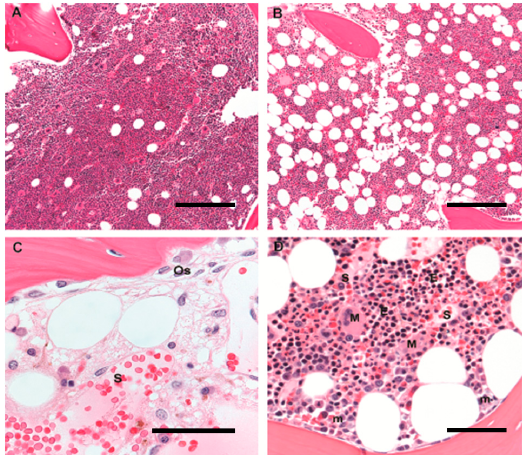
Figure 1. Human marrow architecture in youth and age: Hematopoiesis in human adults is predominantly axial, and diagnostic bone marrow biopsies sample the pelvic iliac crest. Trilineage hematopoiesis is admixed with increasing amounts of mature adipose tissue with age; adipocytes appear as round clear spaces. ( A ) A bone marrow biopsy from a 5-year old child is >90% cellular, with a predominance of trilineage hematopoiesis and little admixed adipose tissue; original magnification 10×; scale bar 100 μ m; ( B ) A bone marrow biopsy from a 60-year old adult is composed of 50% hematopoietic elements and 50% admixed mature adipose tissue; original magnification 10×; scale bar 100 μ m; ( C ) A post-chemotherapy-marrow reveals the underlying bone marrow architecture and microenvironment. Trabecular bone is curvilinear lamellar bone with apposed osteoblasts (Os), and a thin osteoid seam of unmineralized collagen. Dilated thin-walled sinusoids (S) are filled with red blood cells and have closely-apposed stromal cells with ovoid nuclei. Scattered mononuclear cells include plasma cells, mast cells, and macrophages, some of which contain yellow-brown hemosiderin pigment; original magnification 60×; scale bar 25 μ m; ( D ) Erythroid colonies (E) appear as colonies of round cells with dark nuclei and are located away from trabecular bone, close to thin-walled sinusoidal vessels (S); megakaryocytes (M) are likewise located in close contact with sinusoids whereas immature myeloid precursors (m) are localized near trabecular bone. Original magnification 20×; scale bar 50 μ m.